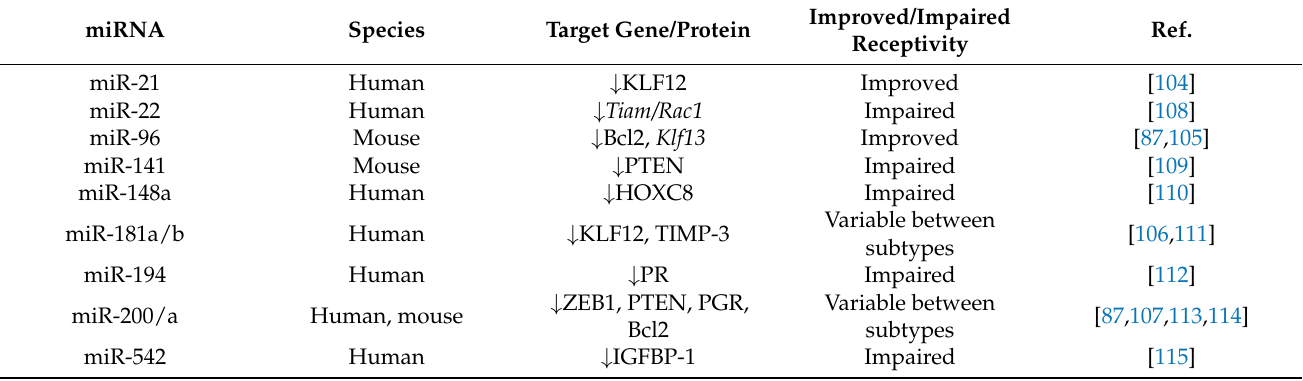
Table 3. The miRNAs identified in endometrial stromal